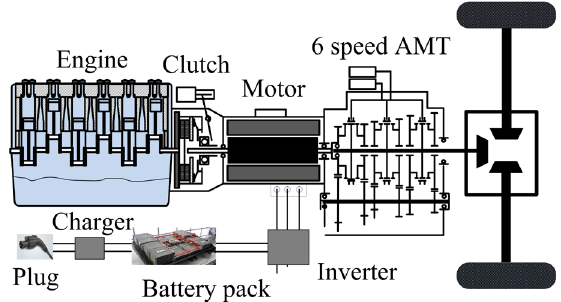
Figure 1. The structure of the PHEB.